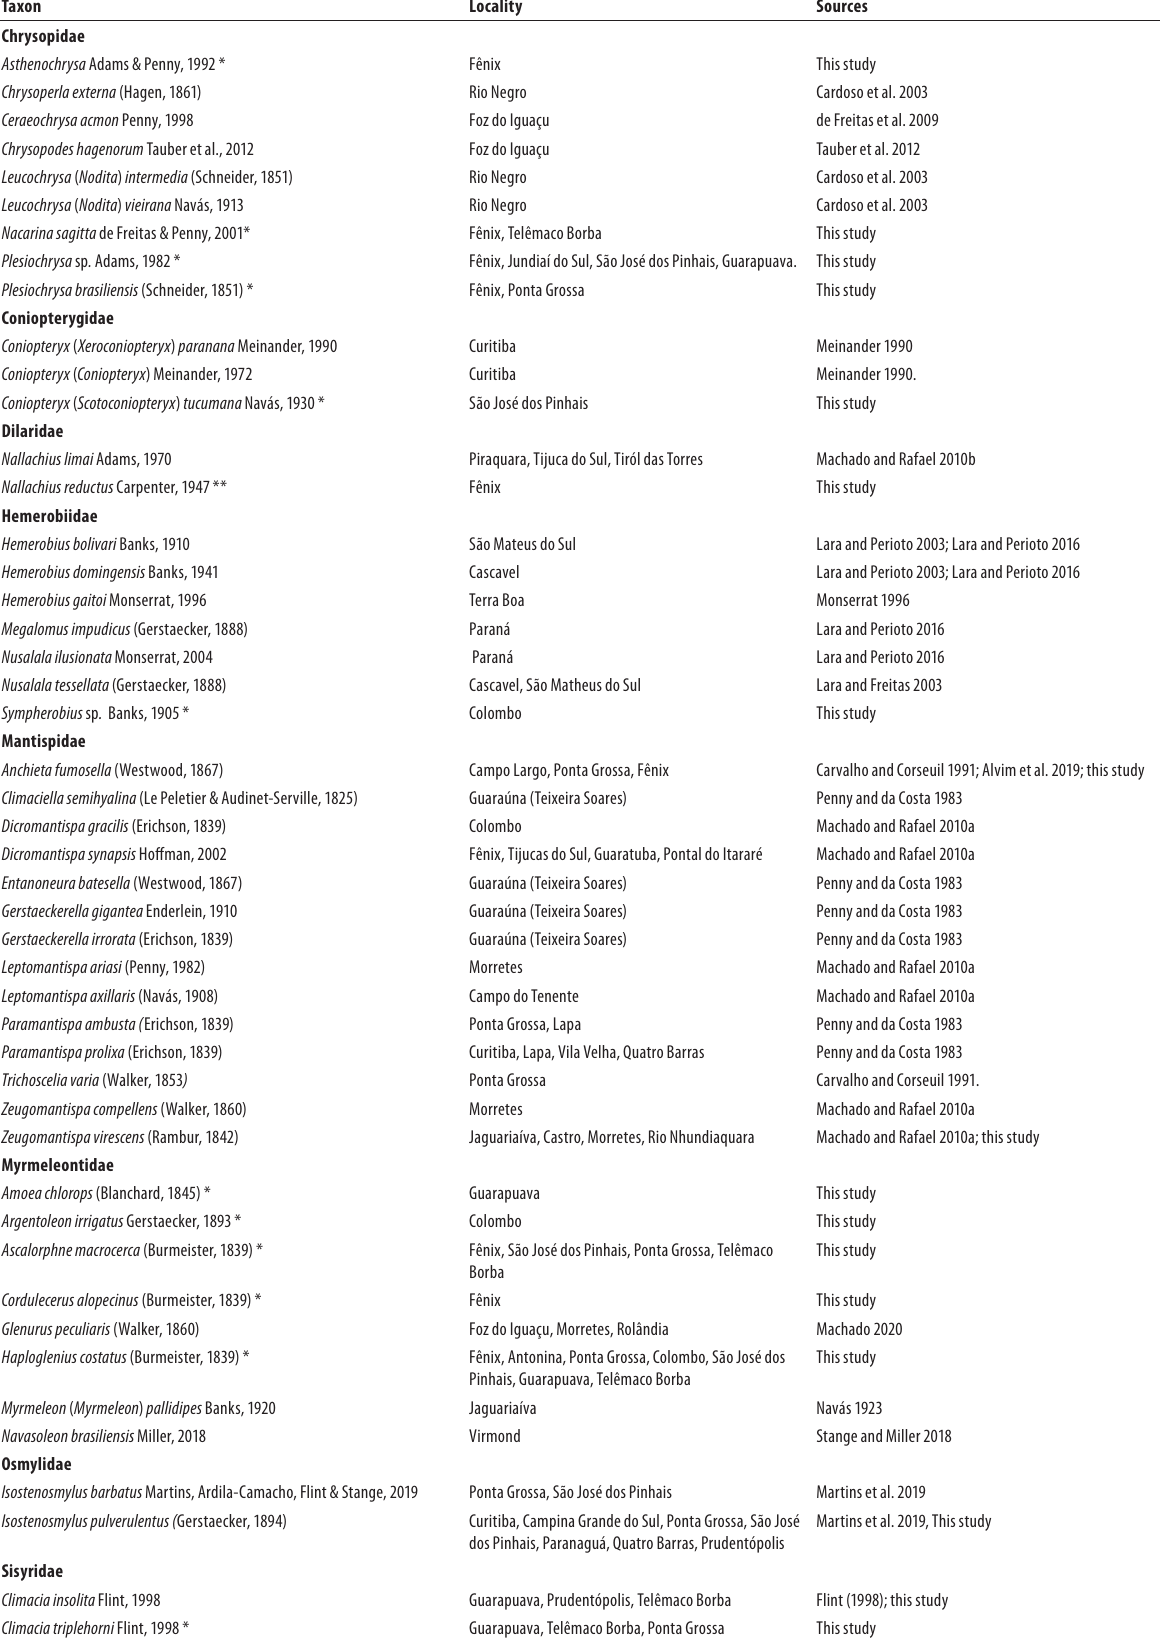
Table 1. Neuroptera recorded from the state of Paraná, Brazil, and the main source of occurrence information. Genera and species indicated with an asterisk (*) represent new records for the state of Paraná, two asterisks (**) represent new records for